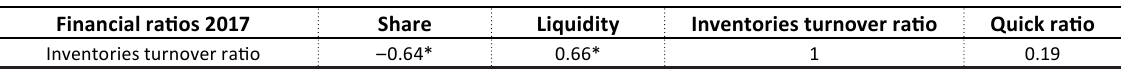
Table 6. Values of correlation coefficients for selected ratios